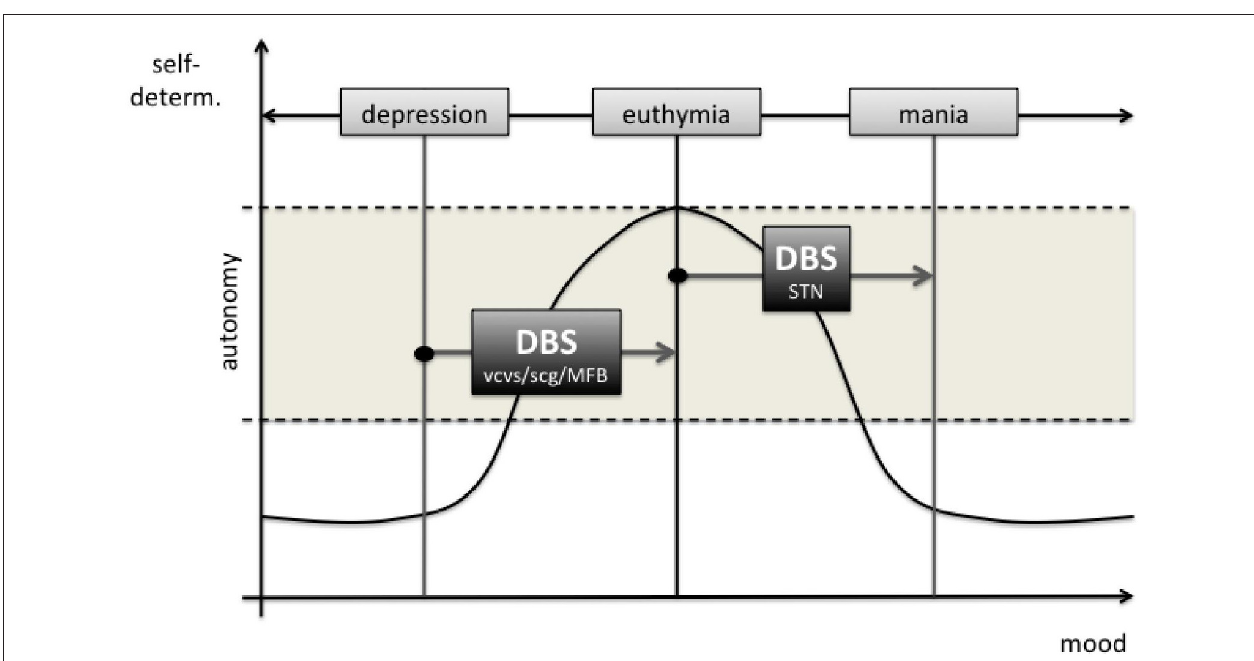
FIGURE 1 | The potential effects of deep brain stimulation (DBS) of the different target regions on patients’ autonomy. In STN DBS mania is a rare ( ca . 4%) side effect. Legend: vcvs, ventral capsule ventral striatum; scg, subgenual cingulate gyrus; MFB, medial forebrain bundle; STN, subthalamic nucleus.